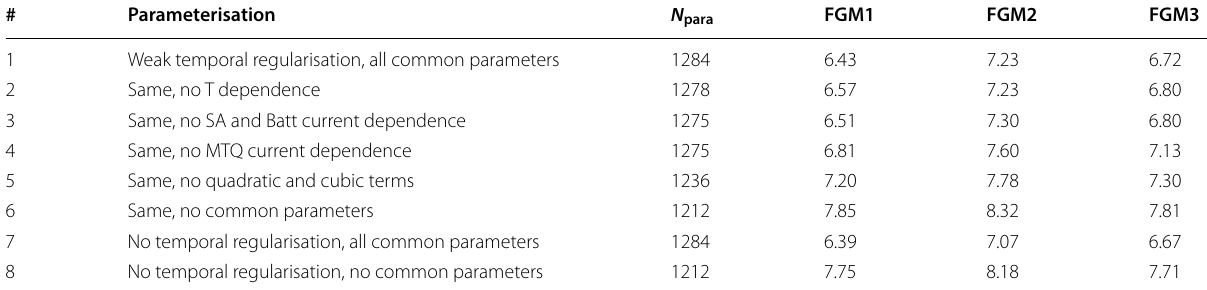
Table 1 Huber-weighted rms misfit (in nT) for various model parameterisations. N para is the number of model parameters